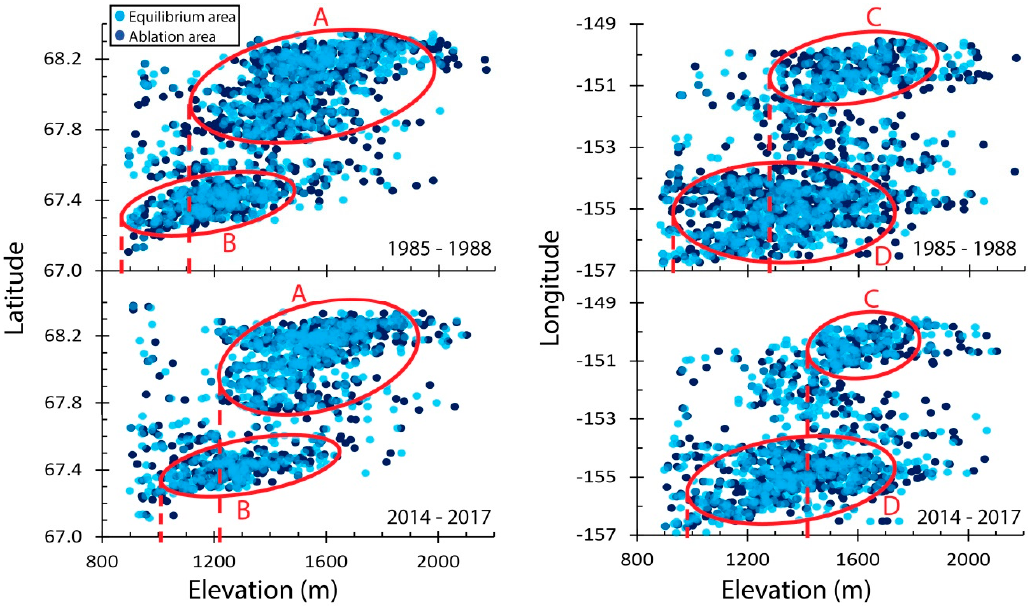
Figure 7. Observed changes in PEs of perennial snowfields’ equilibrium and ablation areas for snowfields persistent over first four years ( top panel) and last four years ( bottom panel) of the study period. PEs were determined by placing a 2 km 2 grid across GAAR and finding lowest elevation points in each cell for equilibrium and ablation areas. The top panel shows snowfields persisting from at least 1985 to 1988 (30 m L4/L5) and the bottom panel shows those persisting from at least 2014 to 2017 (15 m L7/L8). PE changes in latitude are on the left and changes in longitude are on the right. The encircled clusters of PEs indicate the most concentrated areas of snowfields, which correspond to the three localized areas. Cluster A is Kurupa and Nanushuk Rivers; B represents Mount Igikpak; C is Kurupa River and Mount Igikpak; D is Nanushuk River.